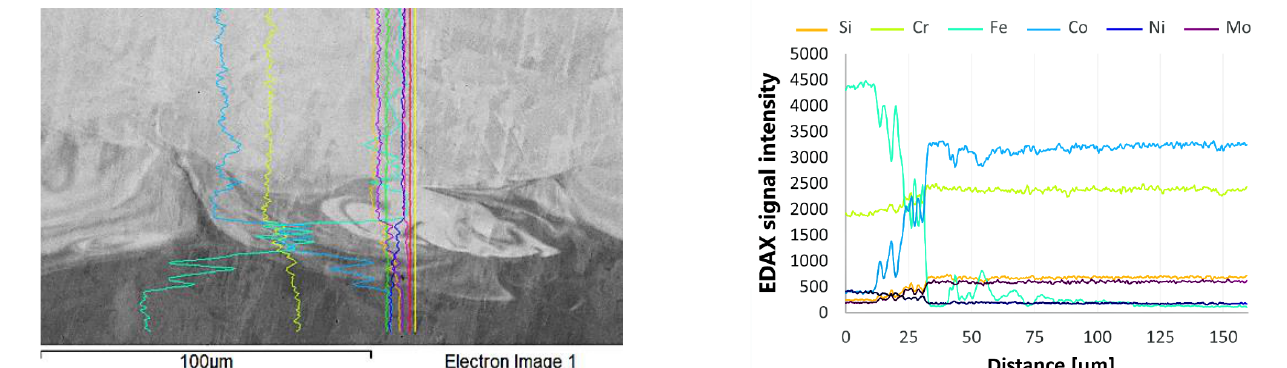
Figure 14. Chemical analysis at the CoCr–304 interface; chemical elements detected—tungsten (W), molybdenum (Mo), nickel (Ni), cobalt (Co), iron (Fe), magnesium (Mg), and chrome (Cr).